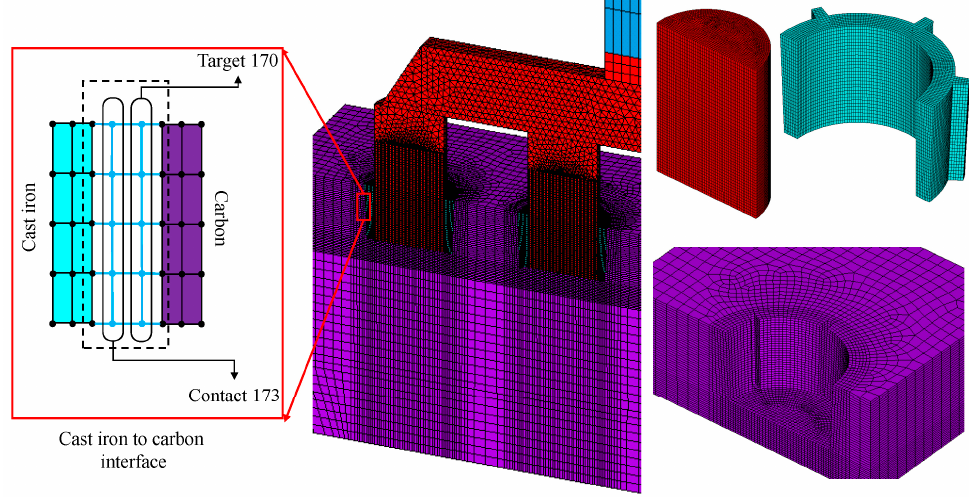
Figure 4. The finite element model with the schematic picture of contact pairs.